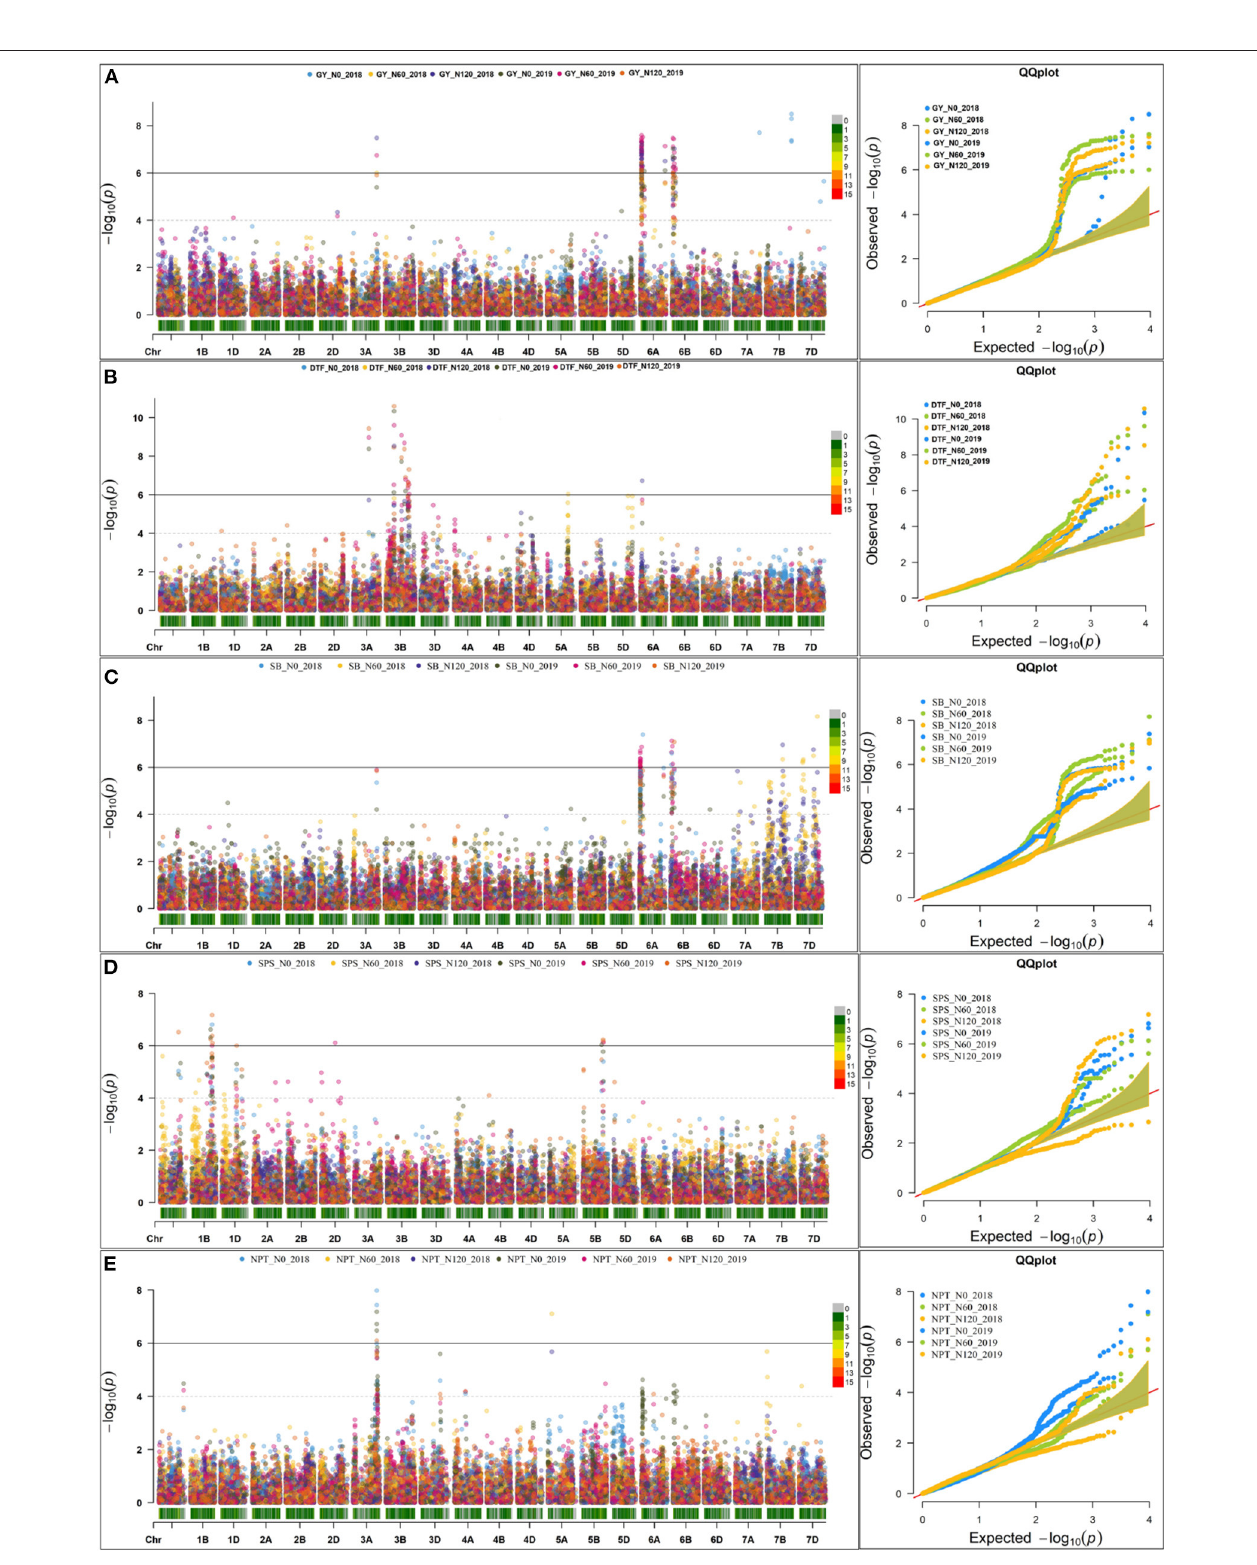
FIGURE 4 | Manhattan plot and qq plot for the yield and yield-related traits across seasons at three different levels of nitrogen (N) (N0, N60, and N120). (A) grain yield (GY), (B) About 50% days to flowering (DTF), (C) shoot biomass (SB), (D) spikelets per spike (SPS), and (E) number of productive tillers.